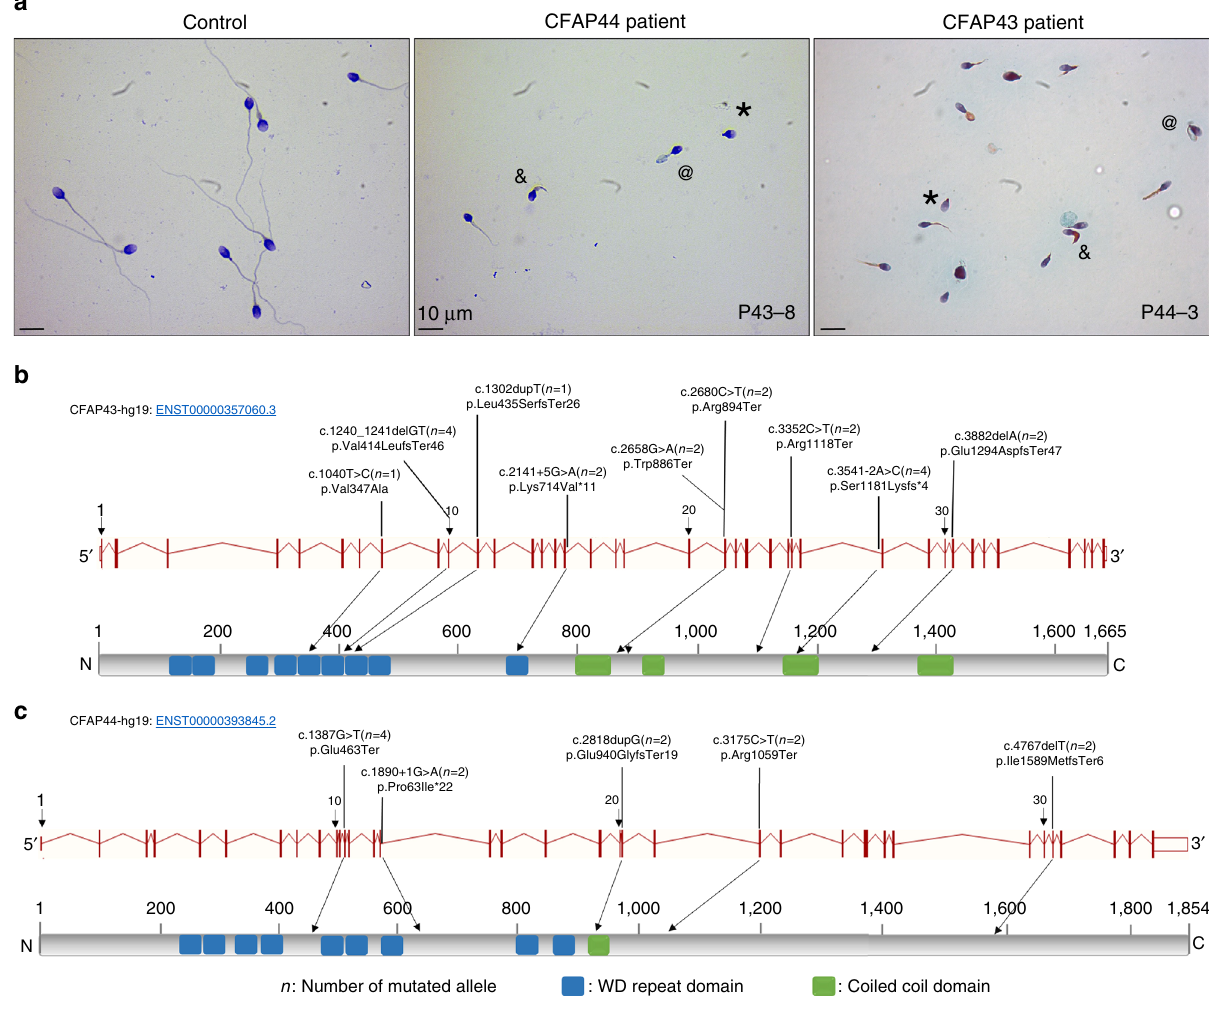
Fig. 1 Morphology of spermatozoa from the patients P 43 -8 and P 44 -3 and position of CFAP43 and CFAP44 mutations in the intron – exon structure and in the protein. a All spermatozoa have a much shorter fl agellum than those of controls. Additional features of MMAF spermatozoa are absent (*), thick (&), and rolled fl agella (@). b Mutations identi fi ed in the CFAP43 gene. c Mutations identi fi ed in the CFAP44 gene. Blue squares stand for WD repeat domains and green squares for coiled-coiled domains as described by Uniprot server. Mutations are annotated in accordance to the HGVS ’ s